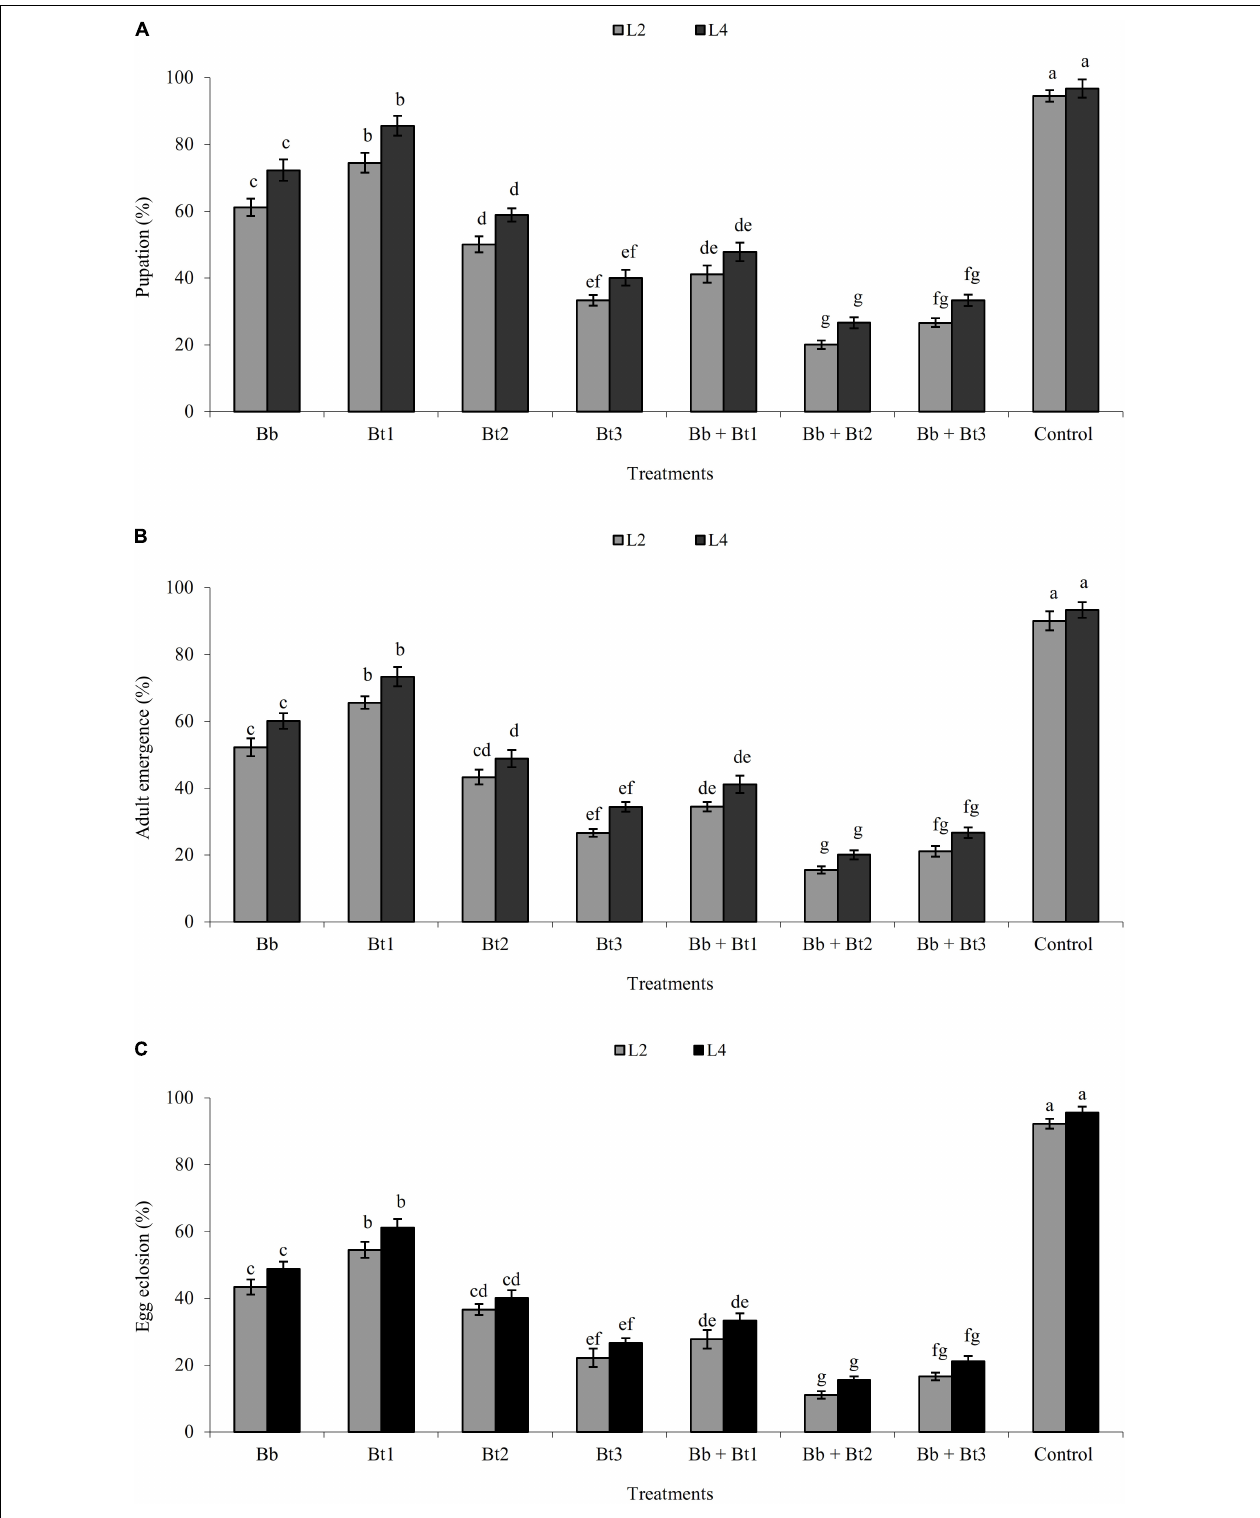
FIGURE 1 | Pupation (A) , adult emergence (B) , and egg eclosion (C) of L2 and L4 instars (mean ± SE)% of H. armigera treated with endophytic B. bassiana (Bb: 1 × 10 8 conidia ml − 1 ) alone and in combination with B. thuringiensis (Bt1: 0.50; Bt2: 0.75; Bt3: 1.0 µ g ml − 1 ). Means followed by the same letter within each larval instar are not significantly different; HSD test P ≤